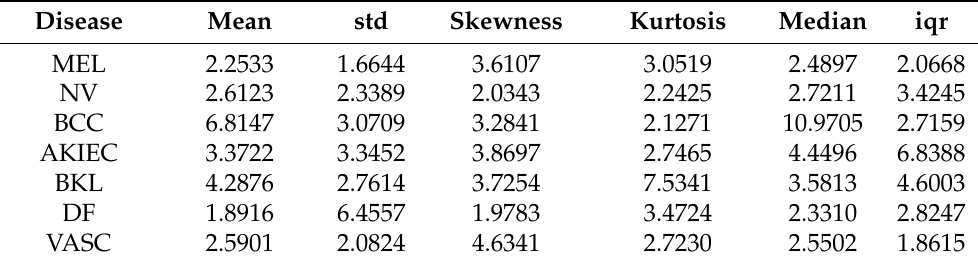
Table 1. Sample M 0 persistence statistics from the X channel of the XYZ color space of images in Figure 4. Reproduced with permission from [32]; published by IEEE,